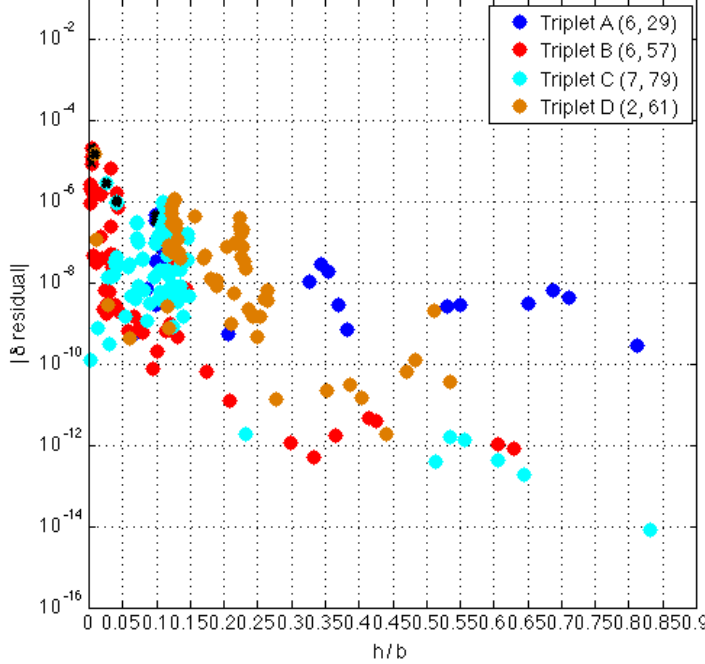
Figure 9. Three-particle dispersion and DKP validity. Scatterplot of absolute value in divergence residual vs. inverse aspect ratio B/H for triplets A to D to determine aspect ratio values for which triplets provide a reasonable estimate of DKPs. An “x” symbol is placed over residual values exceeding twice the SD. Threshold B/H values for triplets A to D are on the order of ∼ 0 . 1, 0.0035, 0.025, and 0.008 corresponding to B/H values of 10, 290, 40, and 125, respectively, defined according to minimum aspect ratio values associated with residuals exceeding twice the SD for each triplet. Numbers in brackets in the legend indicate the number of samples excluded from the three-particle and DKP analysis based on this criterion and the total number of samples (positions) for each triplet